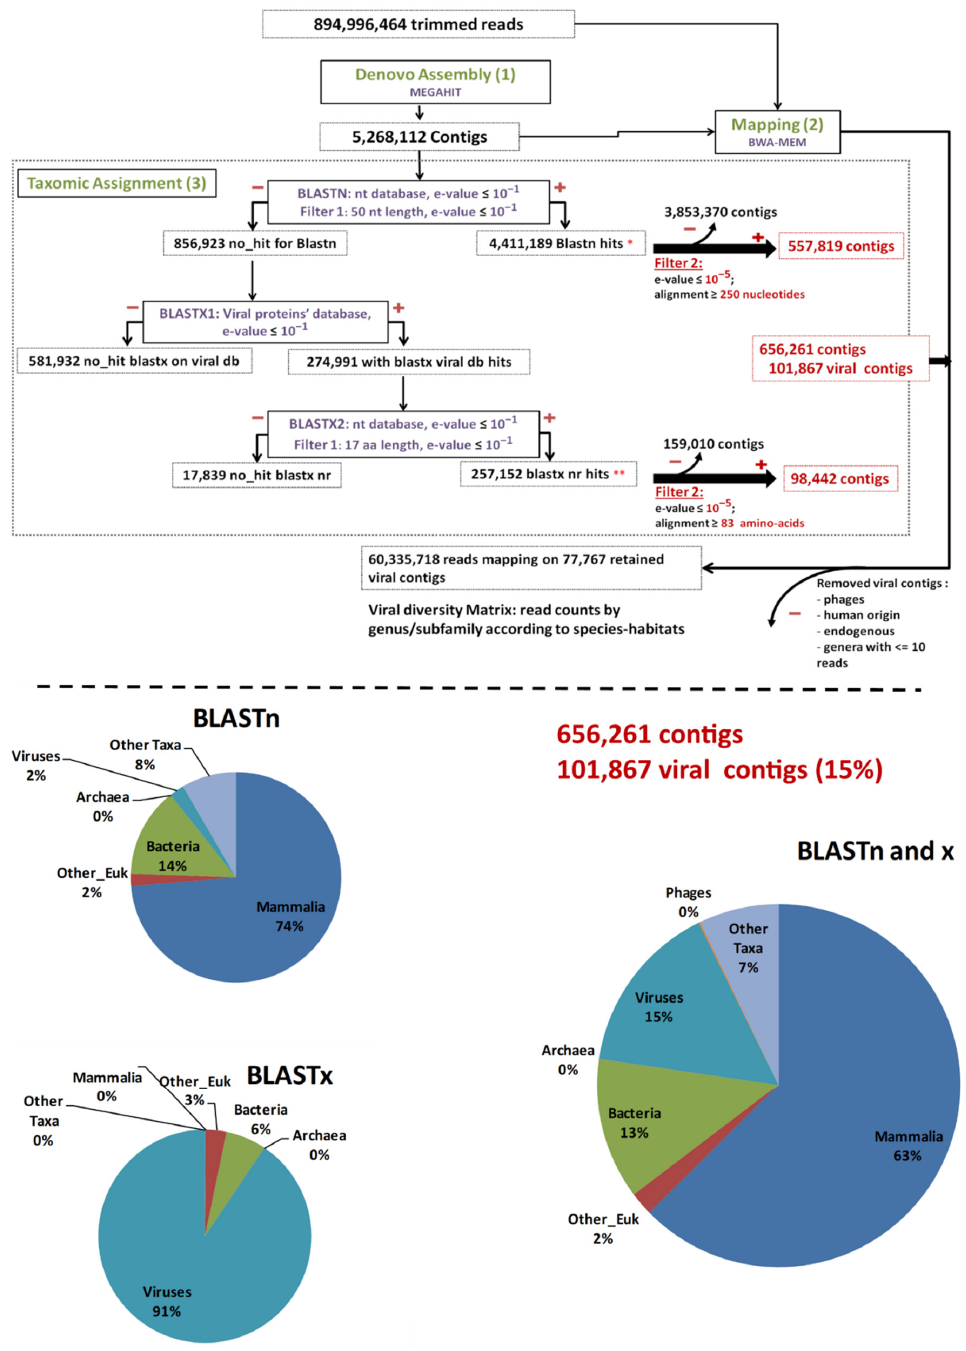
Figure 1. Main bioinformatic processing steps, data streams, and resulting taxonomic categories. “Other_Euk”: Other (non-mammalian eukaryotes).